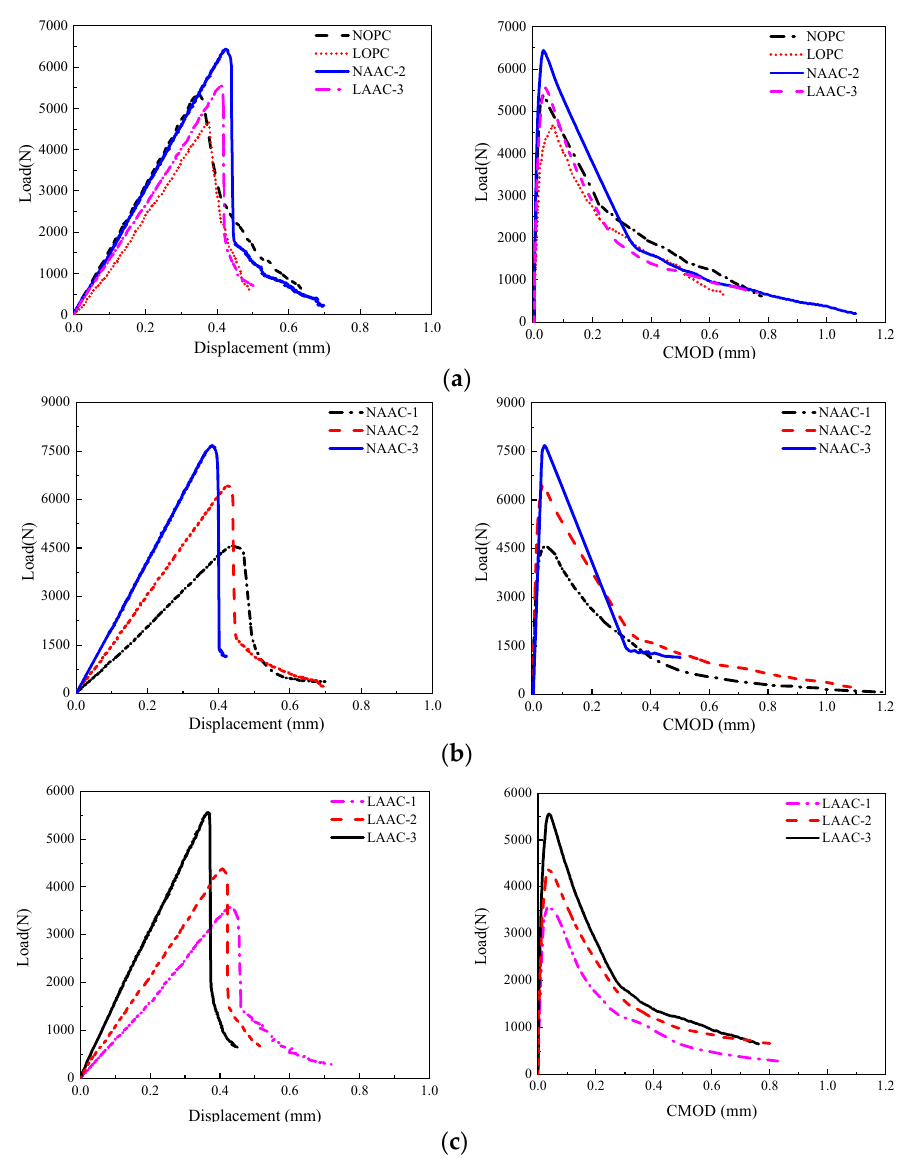
δ 0 represents the displacement at the failure load.